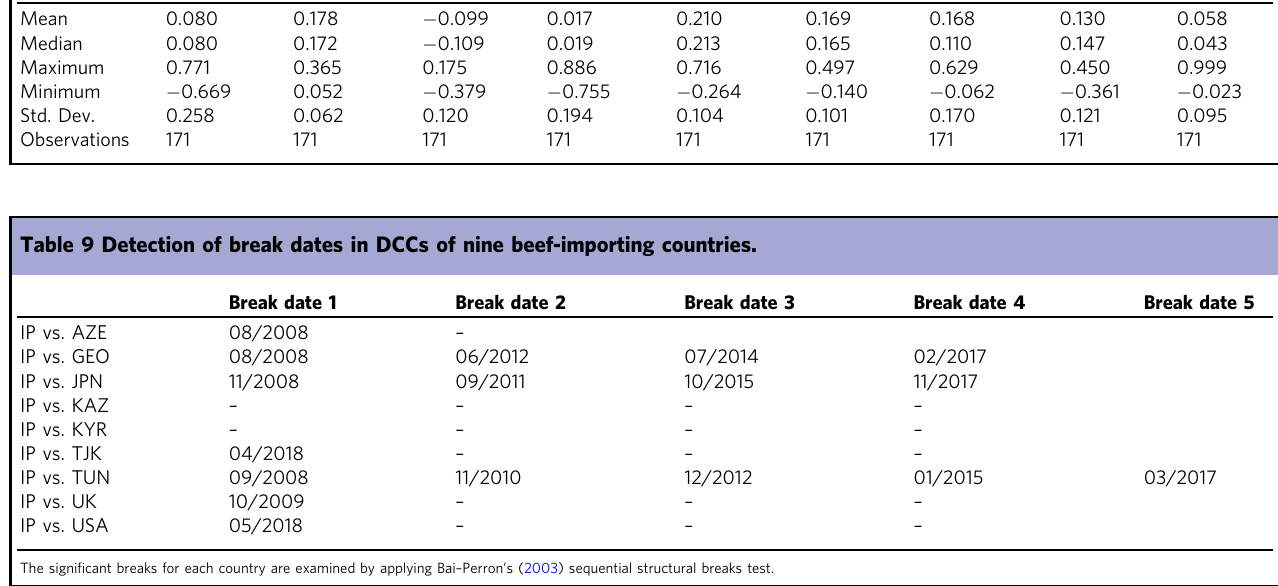
The signi fi cant breaks for each country are examined by applying Bai – Perron ’ s (2003) sequential structural breaks test.